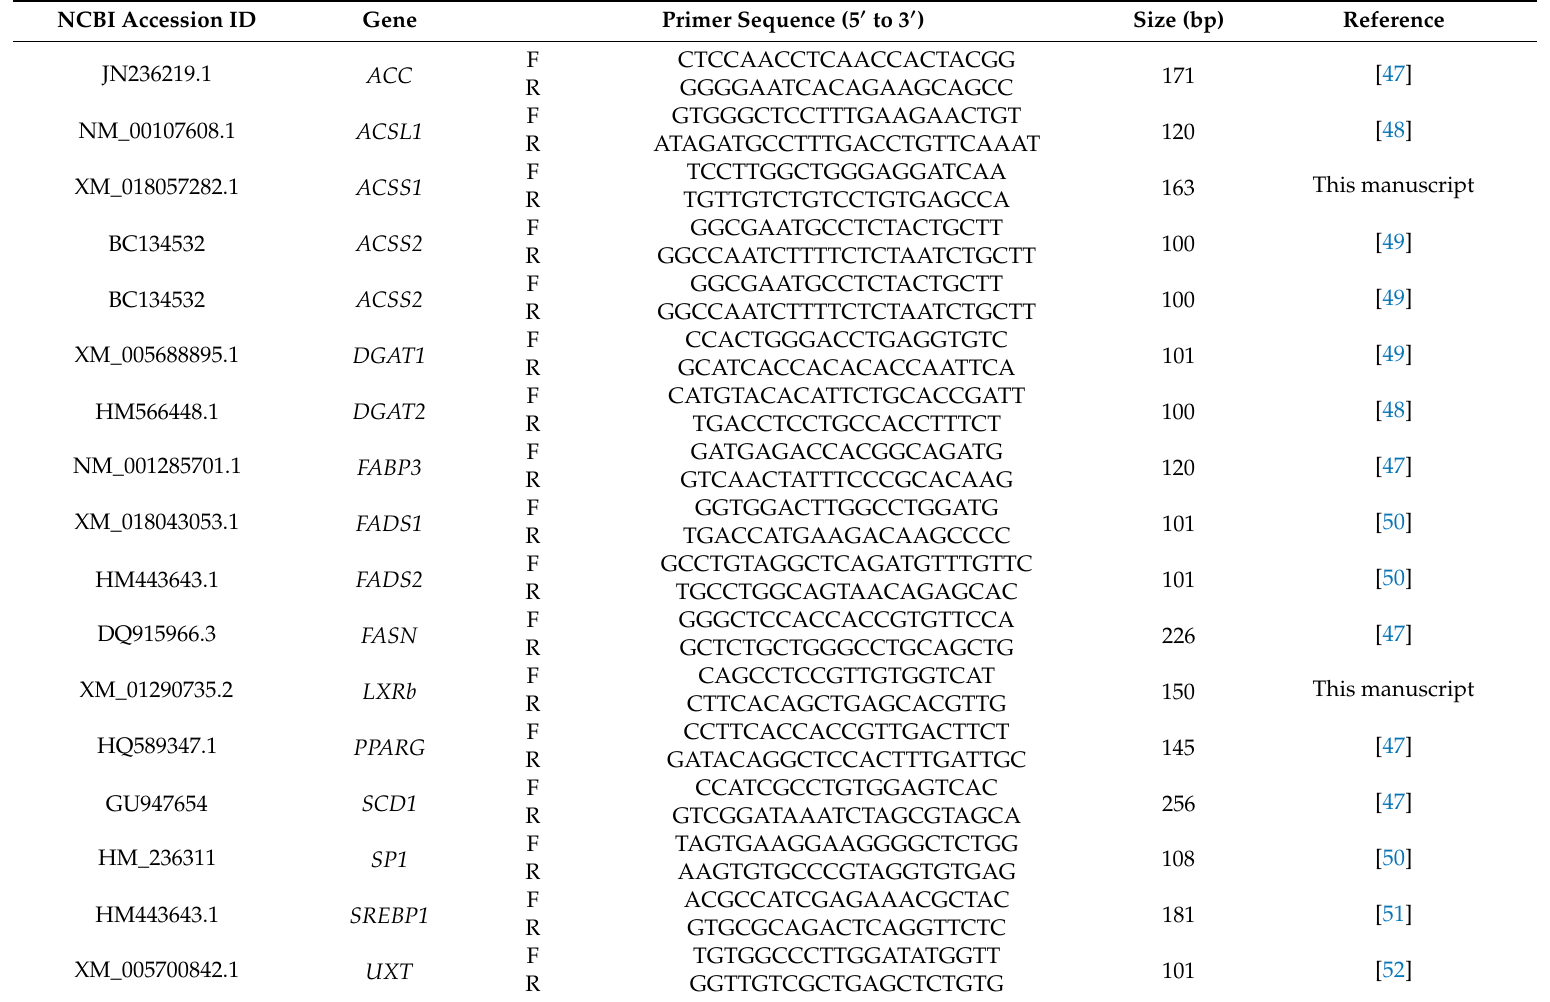
Table A2. Primer sequence for